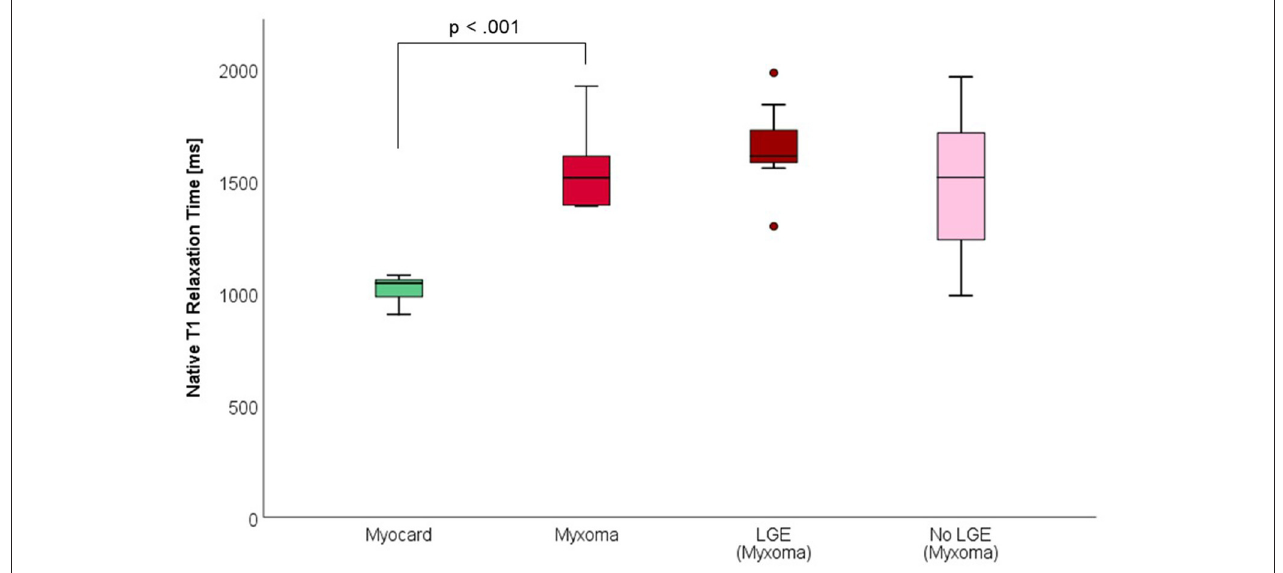
FIGURE 4 | Native T1 Relaxation Times (in milliseconds) of myocardium and myxoma. Where areas with and without LGE were discernible, respective measurements were taken.